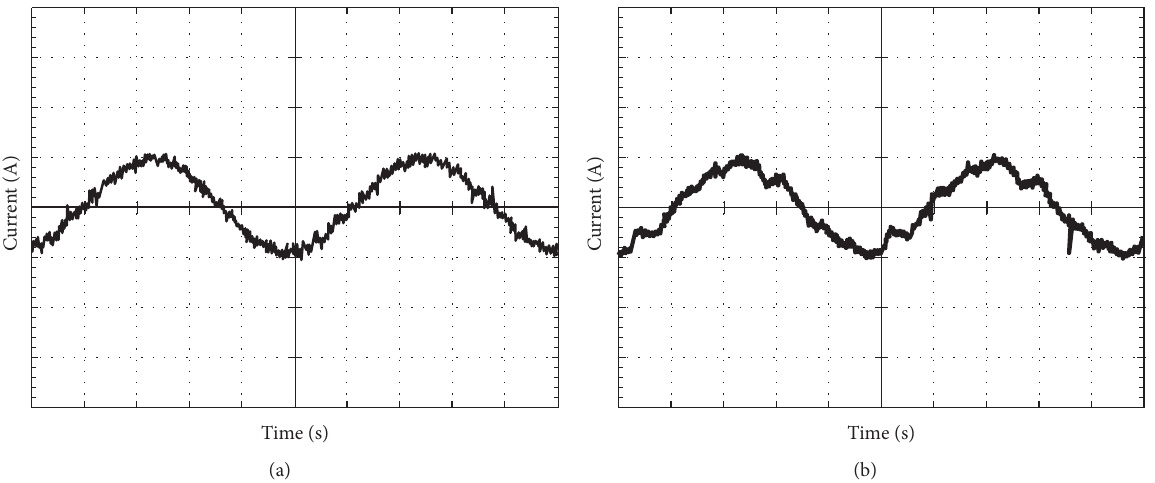
Figure 13: Experimental motor current output to observe the effect of the flux hysteresis band with (a) 2% and (b) 5% of the flux reference value. The current amplitude is 2A/div, and the period is 5 mS/div.